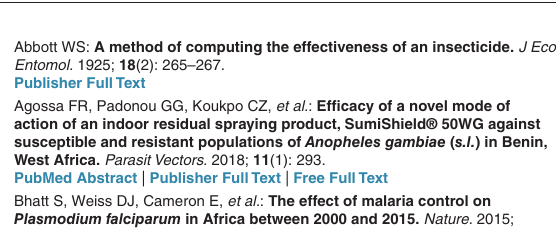
Figshare: A comprehensive testing cascade to identify resistance breaking repurposed insecticides for next generation vector control tools: screening a panel of chemistries against a malaria vector - Raw Data. https://doi.org/10.6084/m9.figshare.c.4490246. v1 (Lees et al. ,